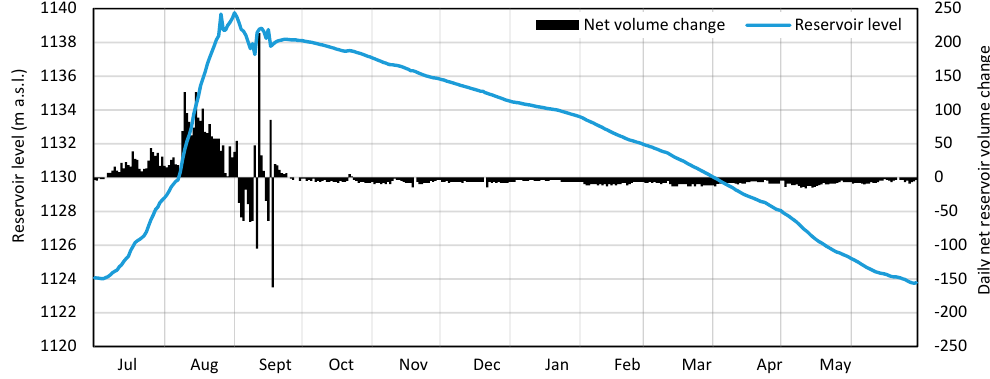
Figure 10. Evolution of the reservoir water levels and daily volume changes for hydrologic year 2018 (Data sources: [37,39,40]).